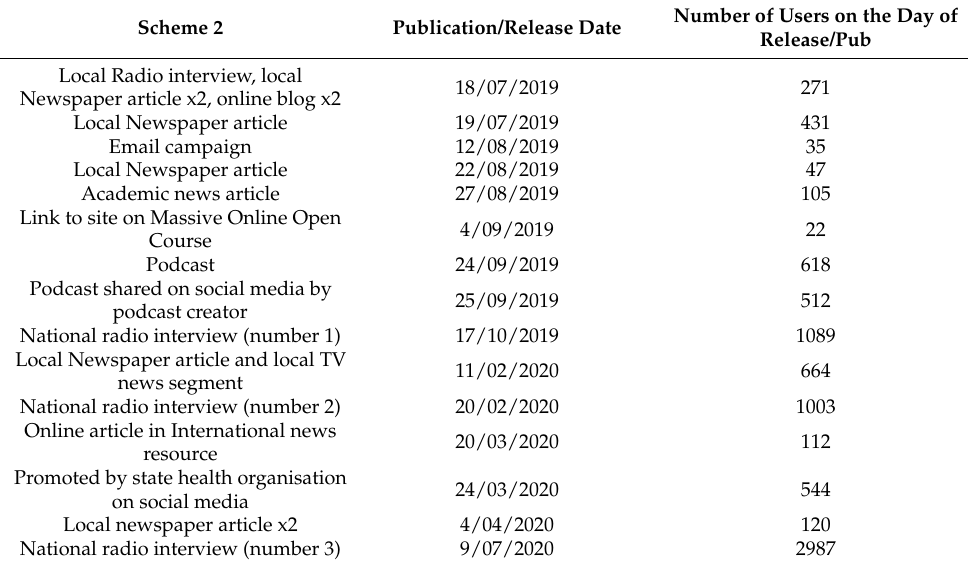
Table 2. Promotional strategy by number of users visiting